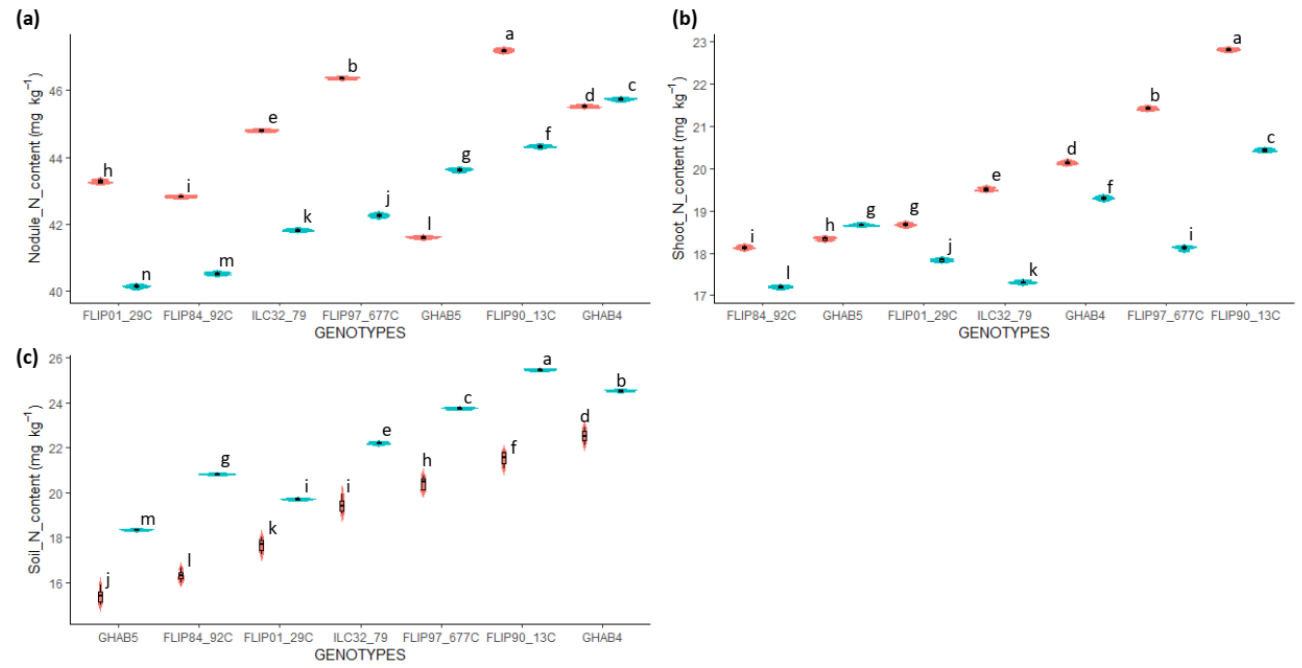
Figure 4. Evaluation of the nitrogen acquisition of the seven chickpea cultivars grown under low-P availability field conditions during the two cropping seasons. Nodule ( a ), shoot ( b ) and soil ( c ) nitrogen content are represented. Data were recorded from nine replicates for each of the two growing seasons from 2018 (red) to 2019 (blue). Letters identify significantly different groups, according to the Tukey test for the multiple mean comparisons at p = 0.05.